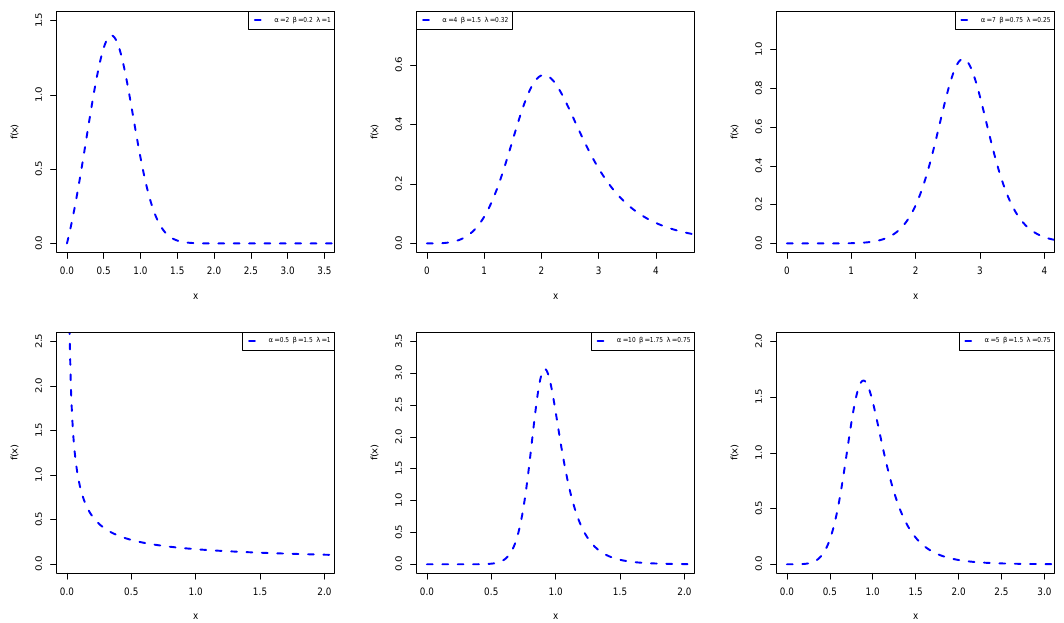
Figure 1. Different possible shapes of the extended odd Weibull exponential (EOWE) density function for several parametric